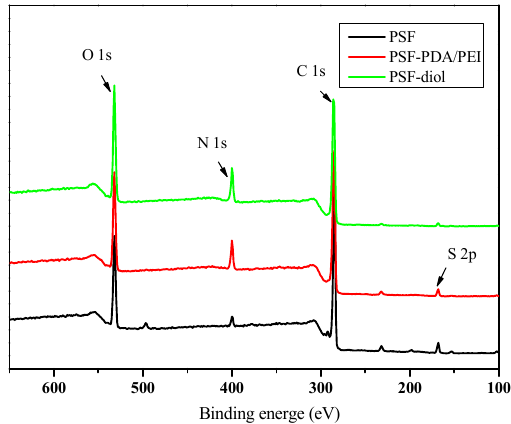
Figure 5. XPS spectra of PSF, PSF-PDA / PEI, and PSF-diol membranes. Table 1. Elemental surface composition of original and modified membranes.